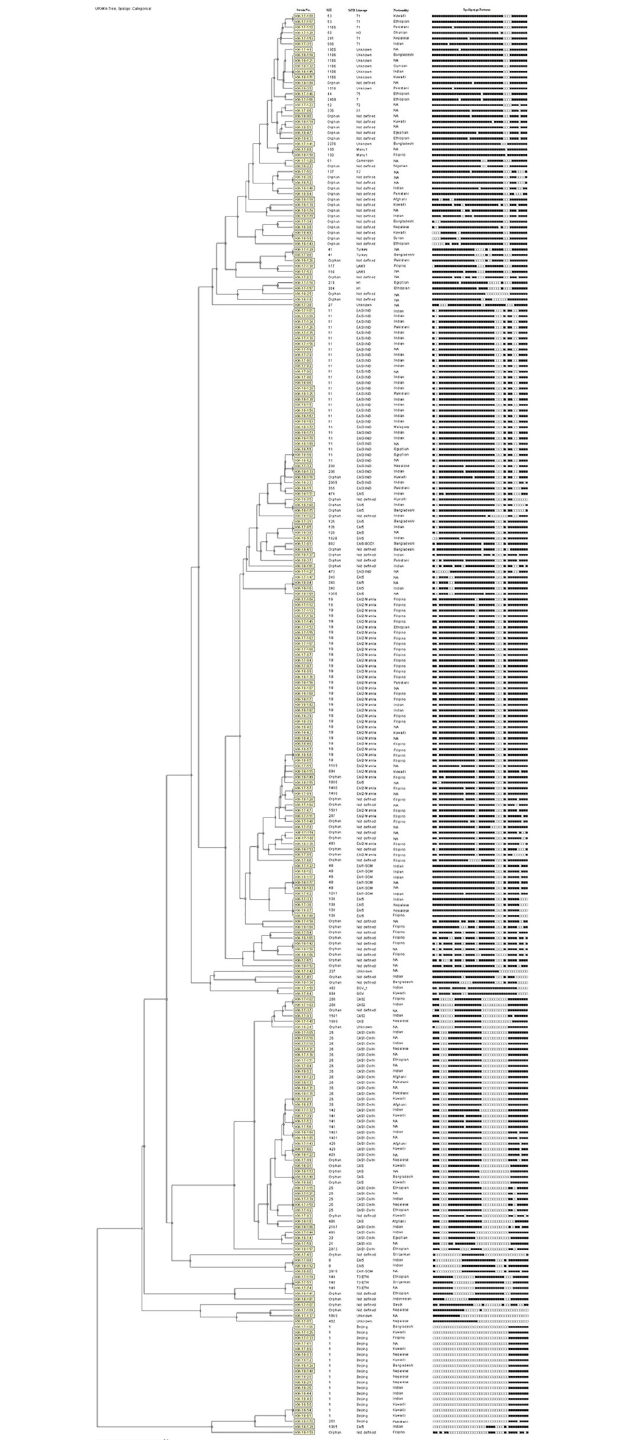
Fig 2. The dendrogram generated from the spoligotyping data using MIRU-VNTRplus database and unweighted pair group method with arithmetic mean (UPGMA) settings for 256 M . tuberculosis isolates from Kuwait is shown. The shared international type (SIT), M . tuberculosis family (Family), nationality of the TB patient yielding the isolate and the actual spoligotyping pattern for each isolate are shown in vertical columns.